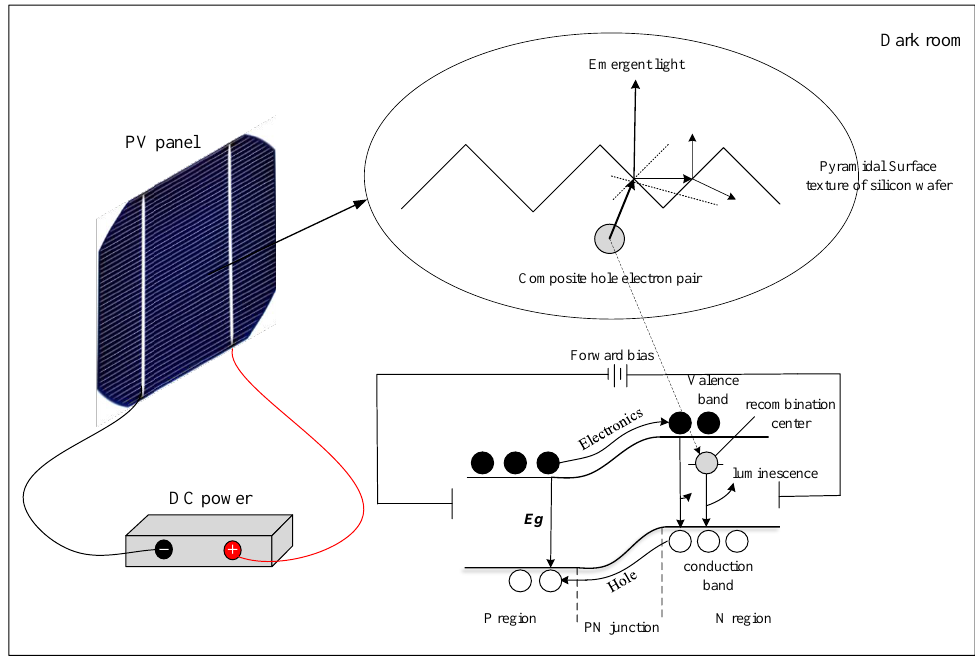
Figure 1. Schematic diagram of electroluminescence.